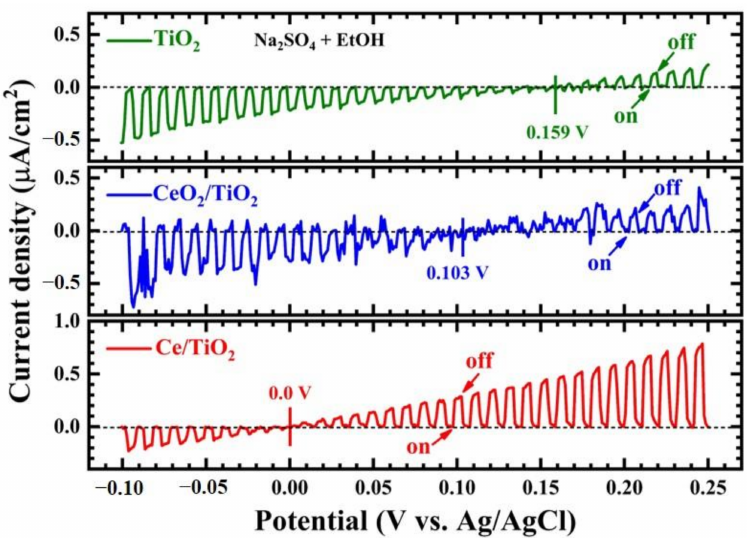
Figure 6. LSV curves for the onset potential from the low-potential region of the pure TiO 2 , CeO 2 - TiO 2 , and Ce/TiO 2